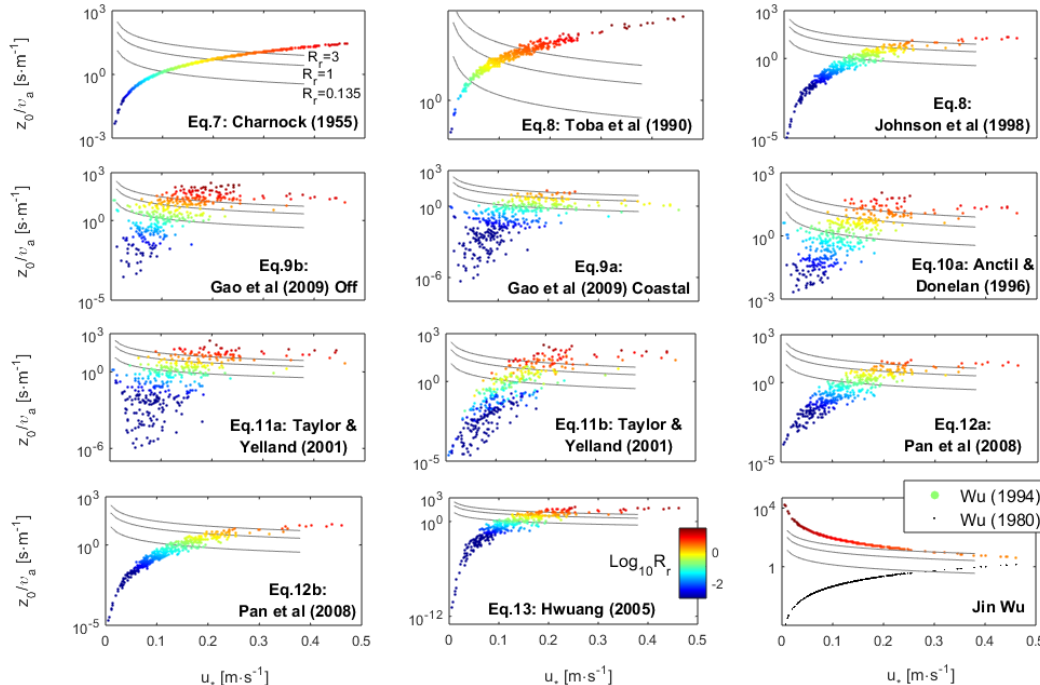
Figure 3. Roughness length (z 0 ) predicted by empirical formulations. Additional parameters used in the plot are u * , kinematic viscosity of air (υ a ) and roughness Reynolds number (R r = z 0 ·u * /ν a ). Wu (1994) label represents Wu [35] formulation for z 0 under rough air-flow. Wu (1980) label represents Wu [100] formulation for z 0 under any air-flow regime.